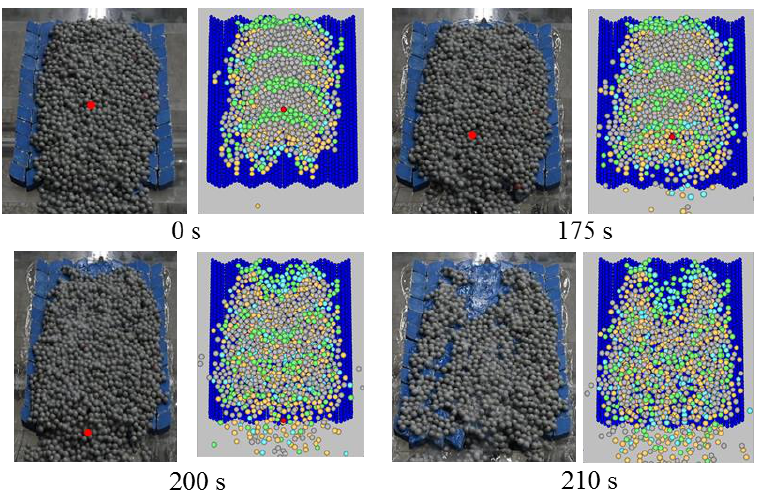
Figure 15. Comparison of physical tests and digital model.